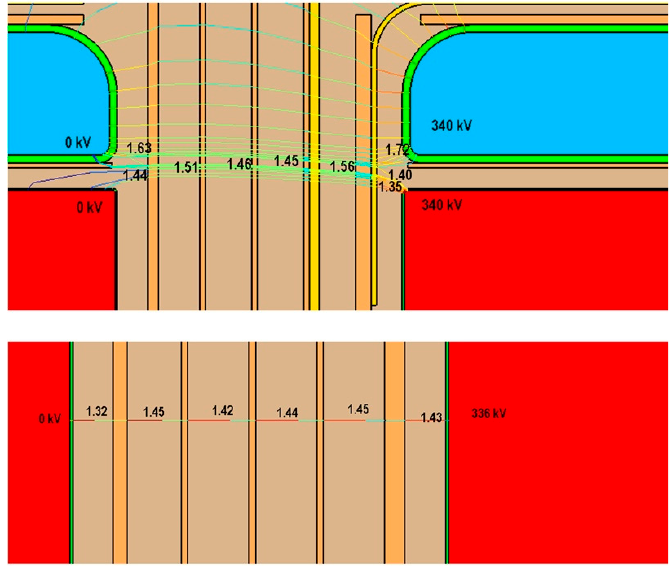
Figure 8. Electric field stress: ( top ) top windings; ( bottom ) HV–LV windings.